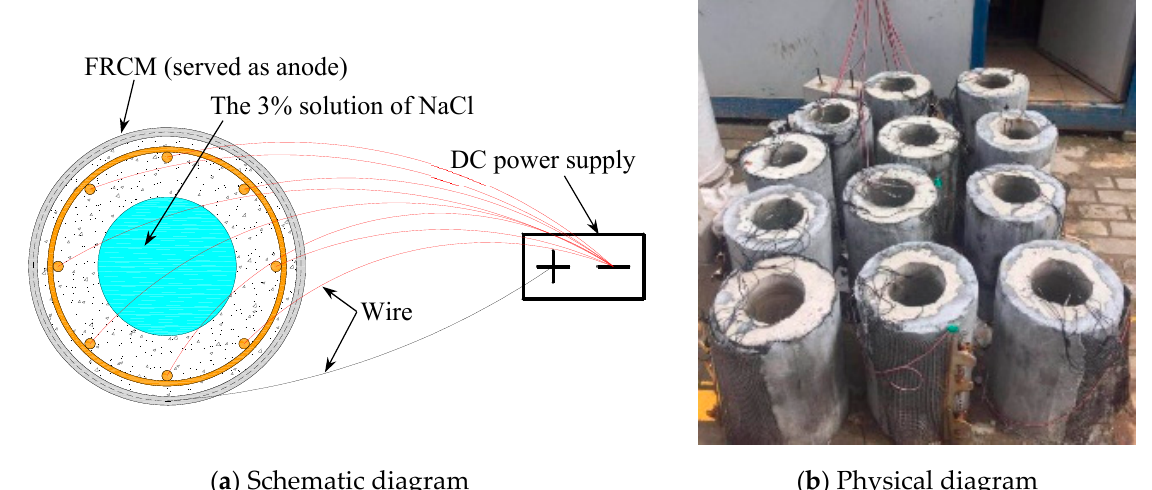
Table 3. Mix design of concrete.